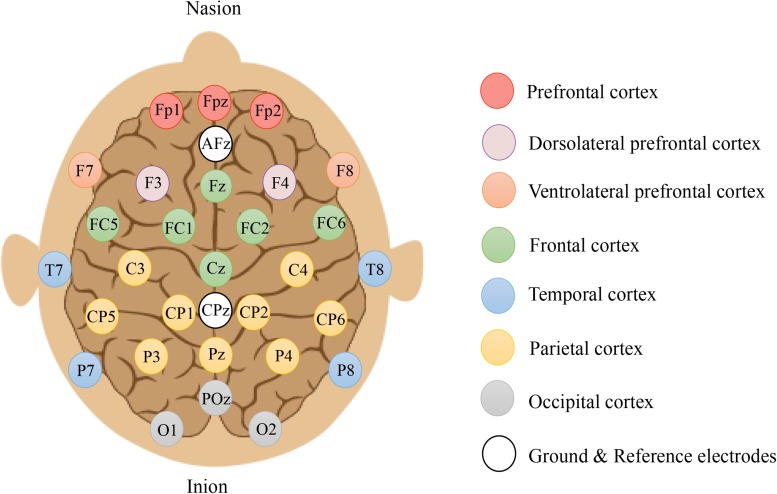
Electrode placement using the Extended International 10–20 system (10% system) covering prefrontal (red circles), dorsolateral prefrontal (purple circles), ventrolateral prefrontal (orange circles), frontal (green circles), temporal (blue circles), parietal (yellow circles), and occipital (gray circles) cortices. Odd numbers = left, even numbers = right, and z = zeros in the midline.